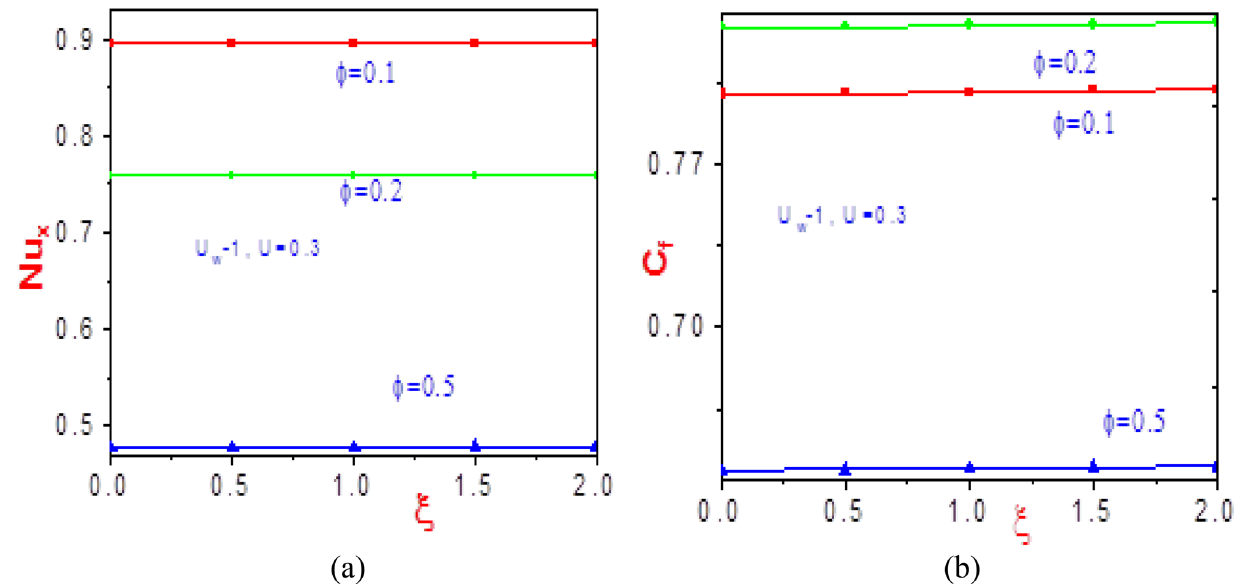
Figure 20. Profiles of ( a ) Nusselt number and (b) shearing stress as a function of nonsimilar parameter (ξ) near the wall (η = 0 ) with different values of φ